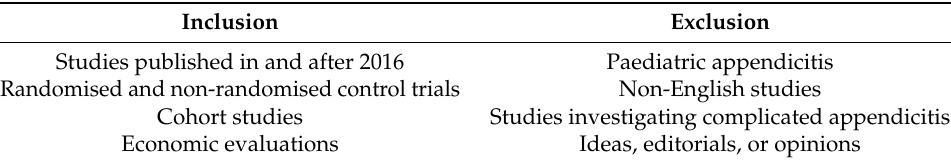
Table A1. Criteria for literature review.